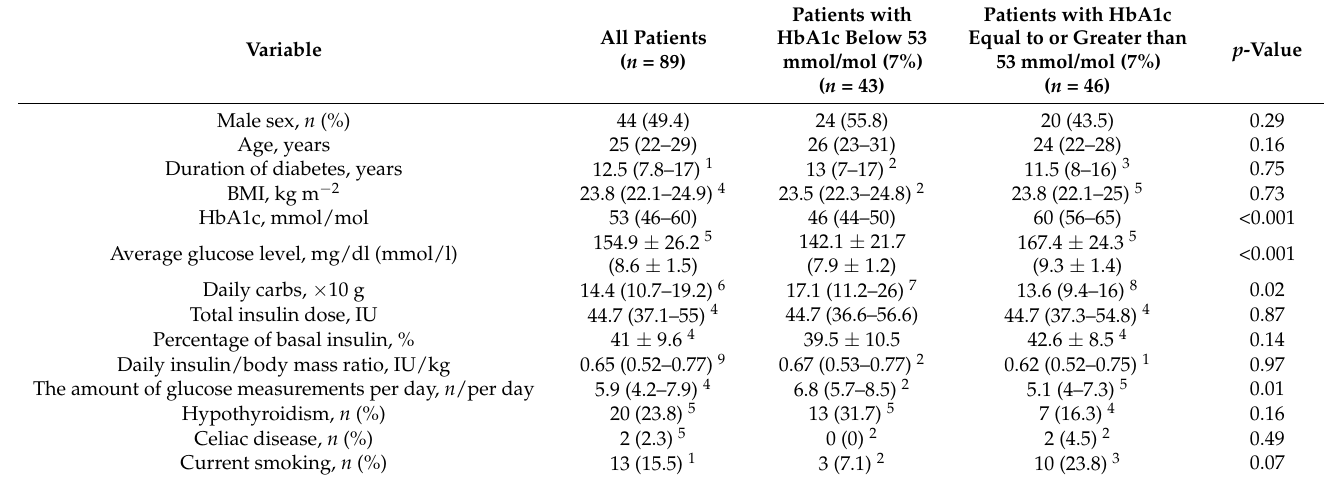
Table 1. The baseline characteristics of patients with glycosylated hemoglobin below and equal to or greater than 53 mmol/mol